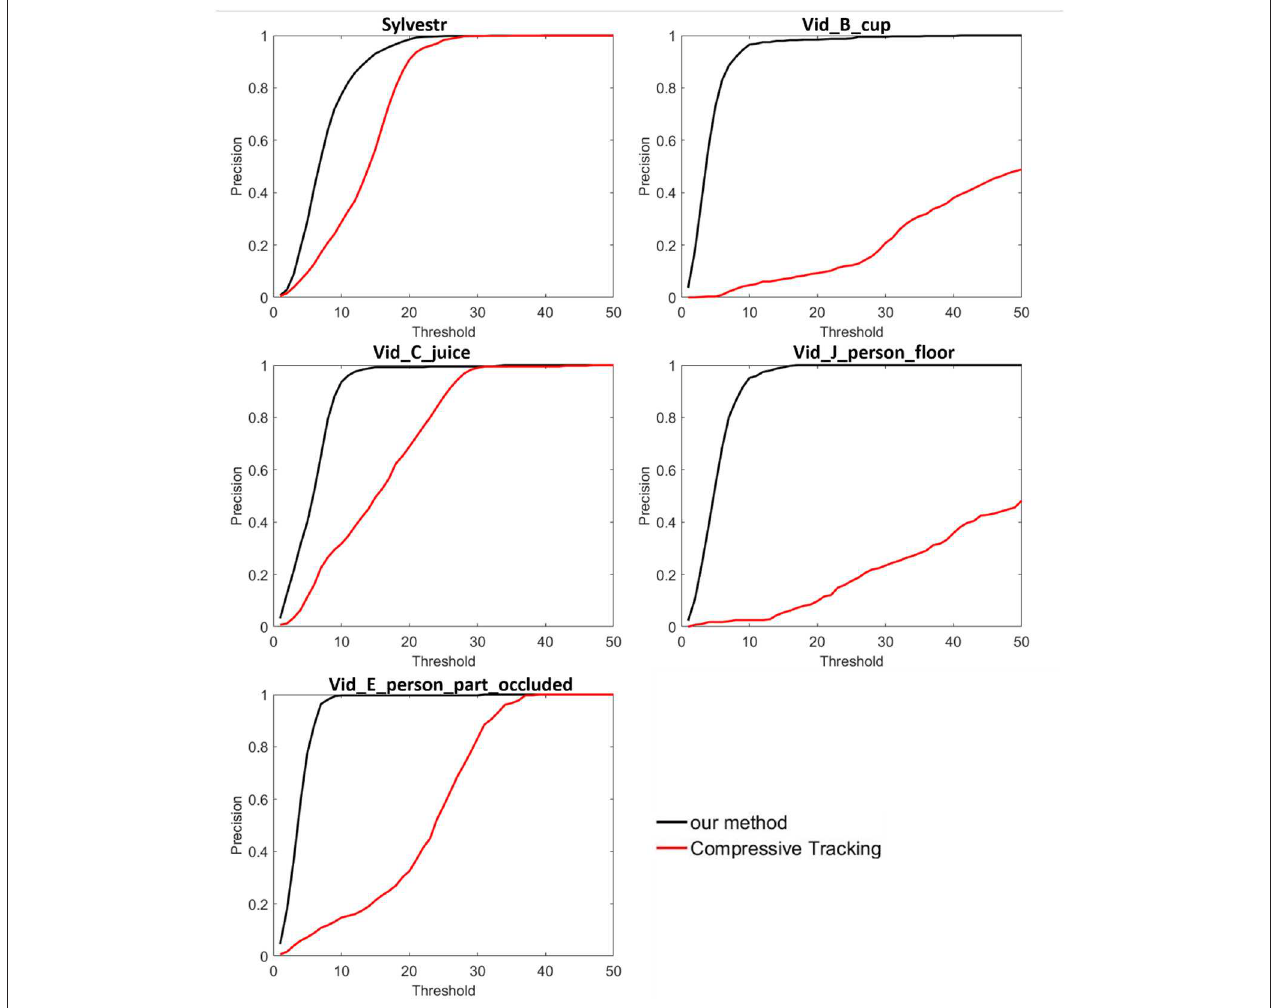
FIGURE 6 | Tracking results on five event-stream recordings captured by DAVIS sensor, compared with the compressive sensing-based tracking